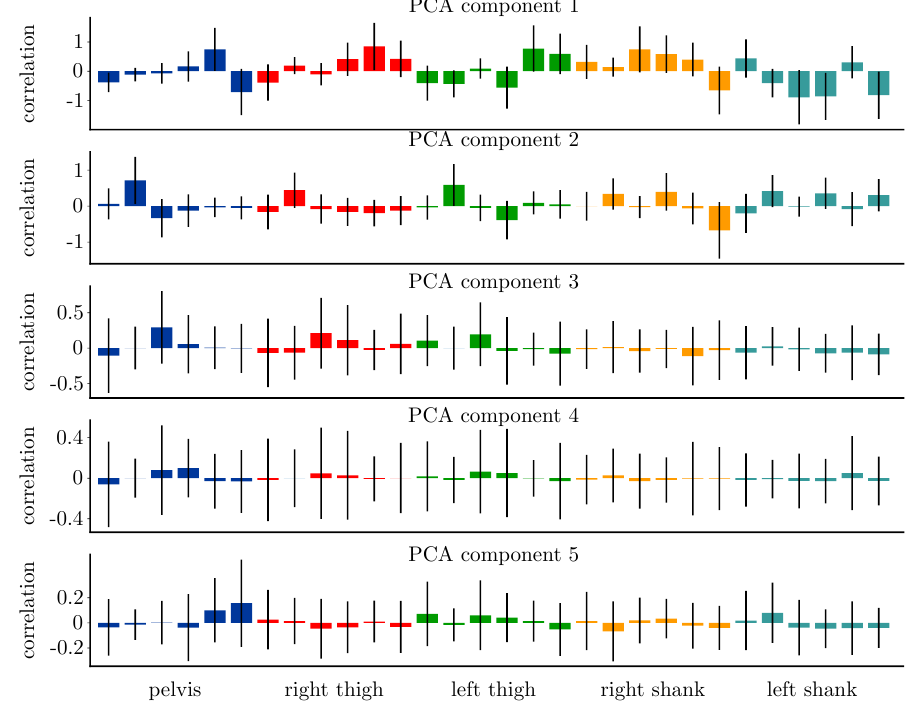
Figure 5. Correlation of each sensor’s reading ( acc x , acc y , acc z , ω x , ω y , ω z ) with the first five PCA components. The correlation strength of the acceleration is, in general, less than that the correlation of the angular rate with the single components. The pelvis and shank sensors show stronger correlations with the PCA components than the thigh